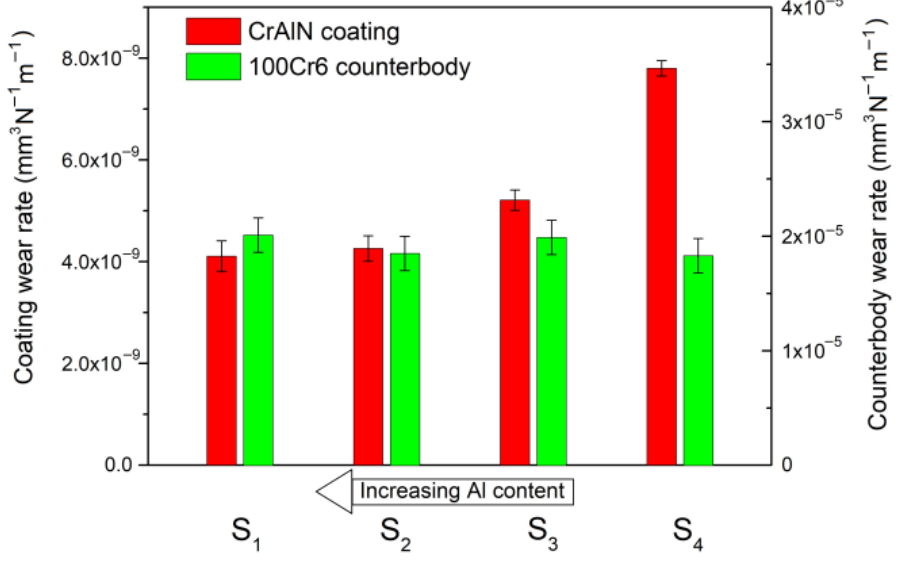
Figure 5. Wear rate of (Cr 1−x Al x )N coating and counter body for (Cr 1−x Al x )N/100Cr6 sliding pair.